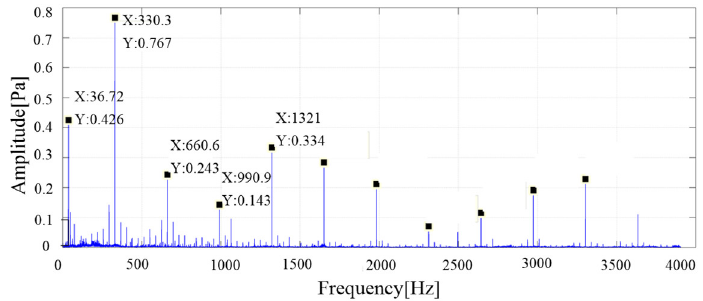
Figure 8. Noise pressure spectrum of the original gear pump test rig.